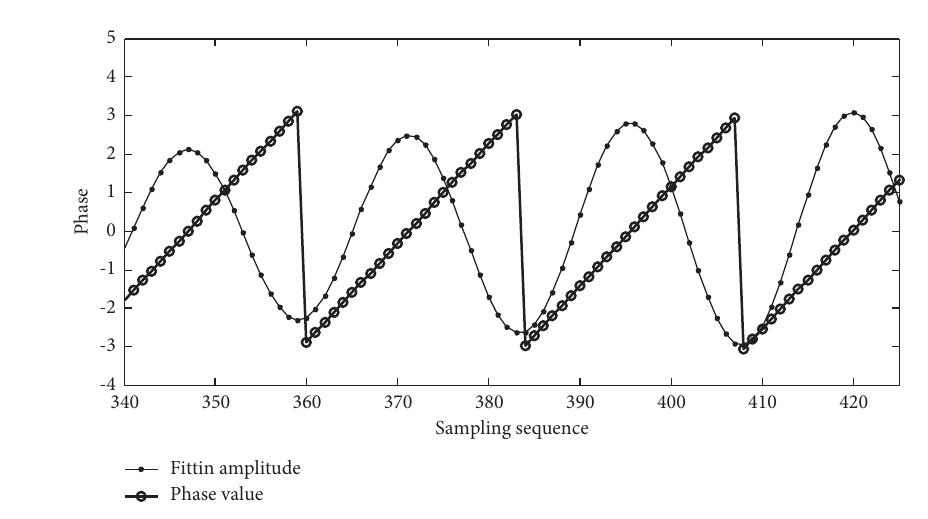
Figure 4: Phase values of the sample points.